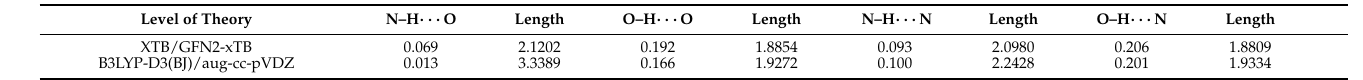
Table 3. Comparison of GFN2-xTB with B3LYP/aug-cc-pVDZ for HB model systems. Local mode force constants (k) are described in mDyn/Å, and length in